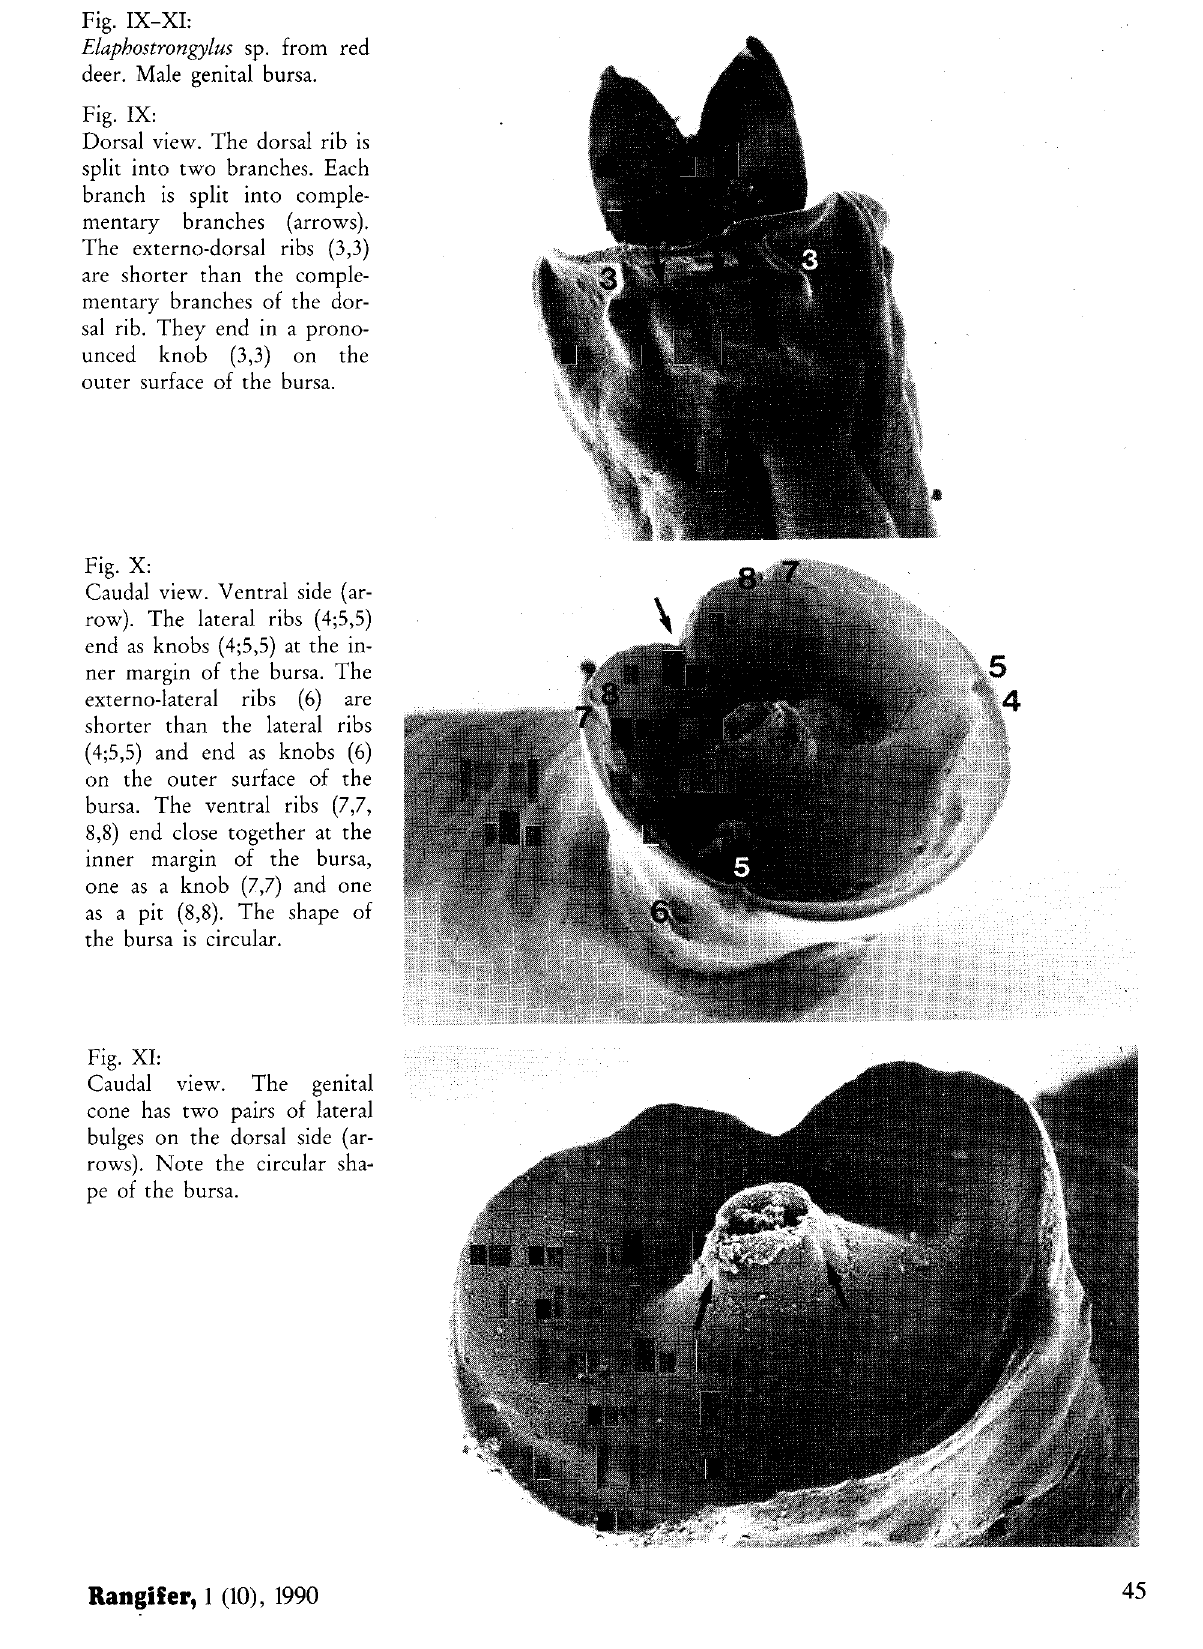
Elaphostrongylus sp. from red deer. Male genital bursa. Dorsal view. The dorsal rib is split into two branches. Each branch is split into comple mentary branches (arrows). The externo-dorsal ribs (3,3) are shorter than the comple mentary branches of the dor sal rib. They end in a prono unced knob (3,3) on the outer surface of the bursa.